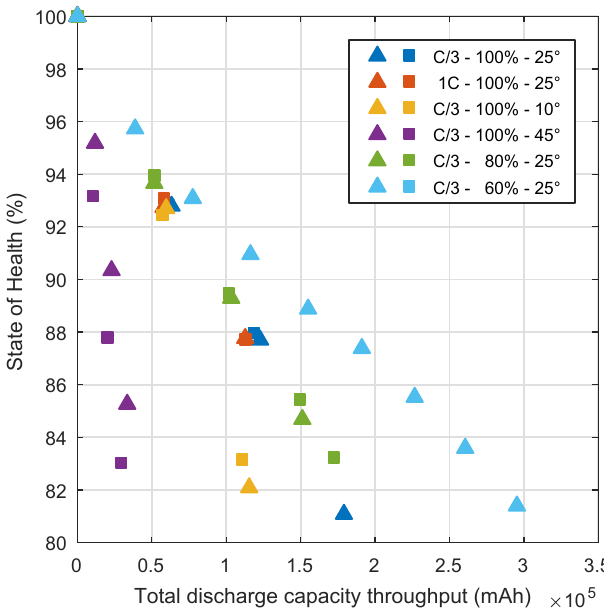
Figure 13. Linear relationship between total discharge capacity throughput (mAh) and the state of health until the EoL criterion (80% SoH), for all tested Si-alloy cells under different cycling